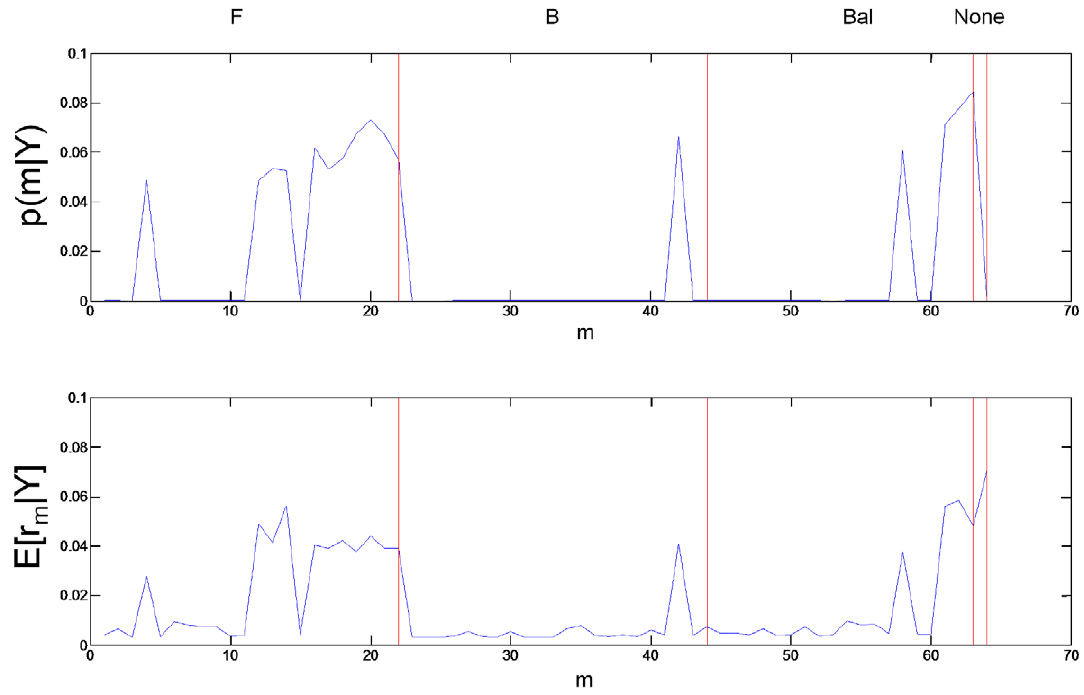
Figure 5. Model level inference for modulatory families. For FFX (top panel) the figure shows that models in the F and BAL families have most probability mass. The expected posteriors from the RFX inference show a similar pattern (bottom panel). The ordering of models in this figure is not the same as the ordering of P models in figure 4.